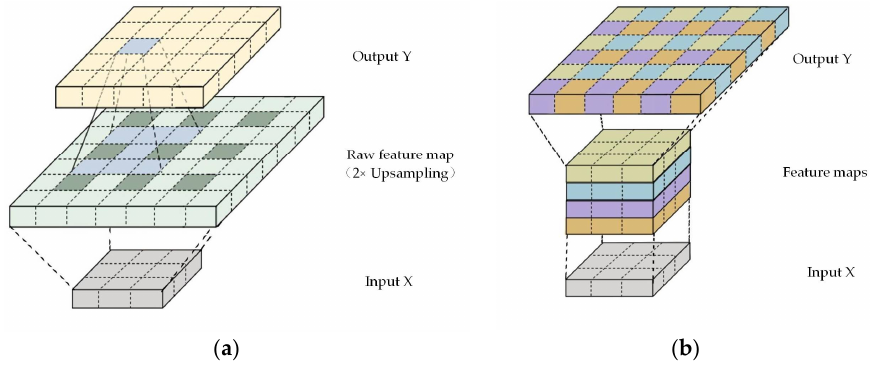
Figure 5. Example of: ( a ) transpose convolutional layer; and ( b ) sub-pixel convolution layer.